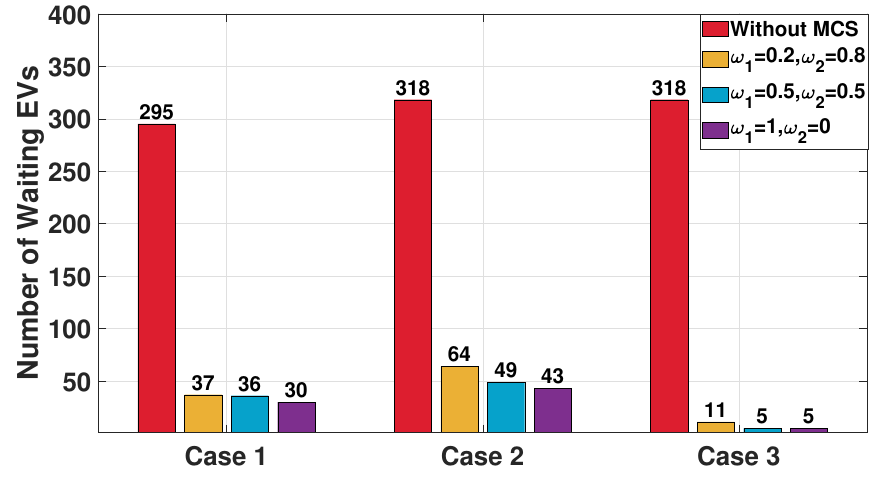
Figure 16. Comparison of the total number of waiting EVs with and without MCS in terms of different weights for three